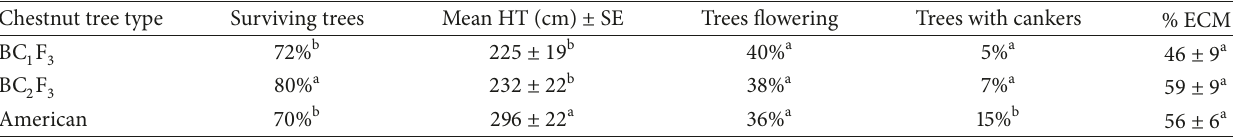
Table 1: Comparison of survival, height, flowers, cankers, and percent ectomycorrhizal (ECM) fungal root colonization on eight-year-old chestnut tree types (pure American, BC 1 F 3 , and BC 2 F 3 ) on a reclaimed mine site in Dresden OH, USA. Means sharing common letters do not significantly differ at 𝛼 = 0.05 to Tukey’s HSD.